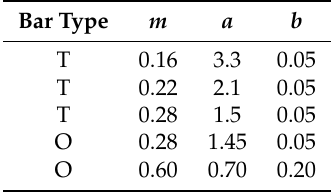
Figure 22. Mean discharge coefficient    as a function of the incoming flow q , for circular bars with void ratio m = 0.28.